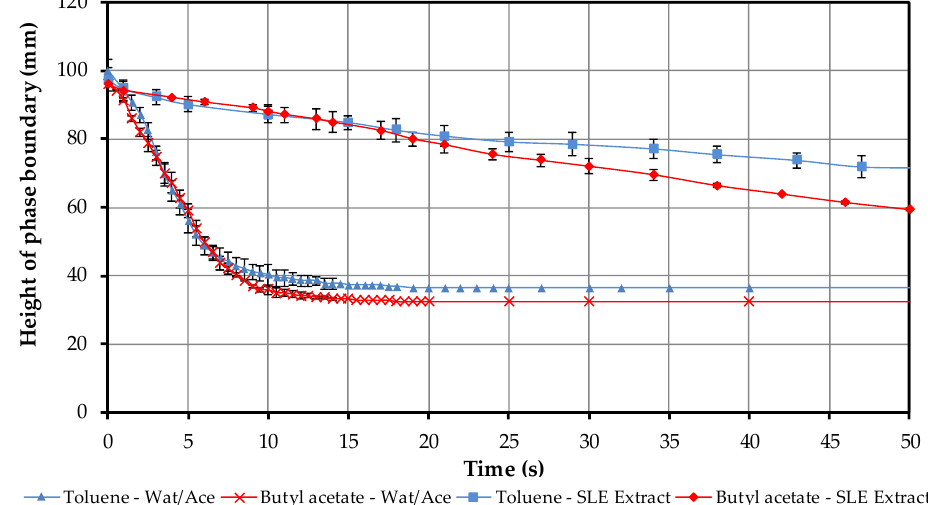
Figure 6. Comparison of settling behavior between toluene–water/acetone (blue) and butyl acetate–water/acetone (red) as well as toluene–SLE extract (blue)and butyl acetate–SLE extract (red) at 1 min stirring time and a speed of 400 rpm. The top phase is continuous and it starts to sediment more quickly than the dispersed bottom phases.